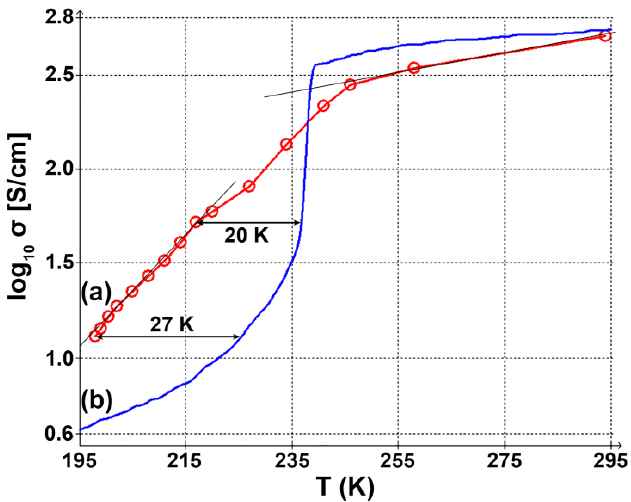
Figure 6. Temperature dependence of electrical conductivity (logarithmic scale). ( a ) V 4 O 7 film, ( b ) V 4 O 7 single crystal (data from [4]).